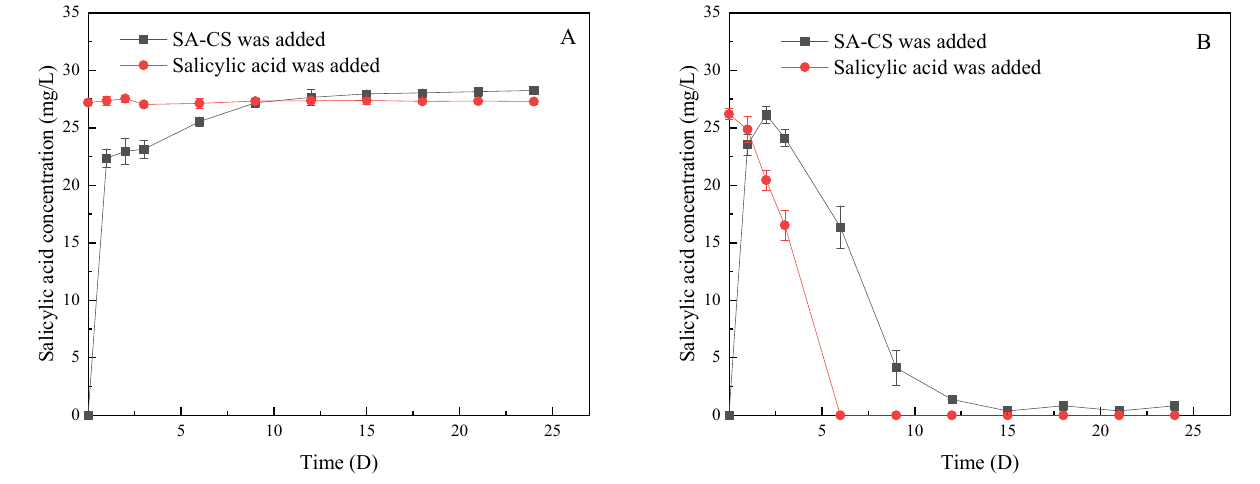
Figure 1. Influence of the light and dark conditions on SA in water: ( A ) shows the effect of darkness on SA and SA-CS; ( B ) shows the effect of light on SA released from SA and SA-CS.